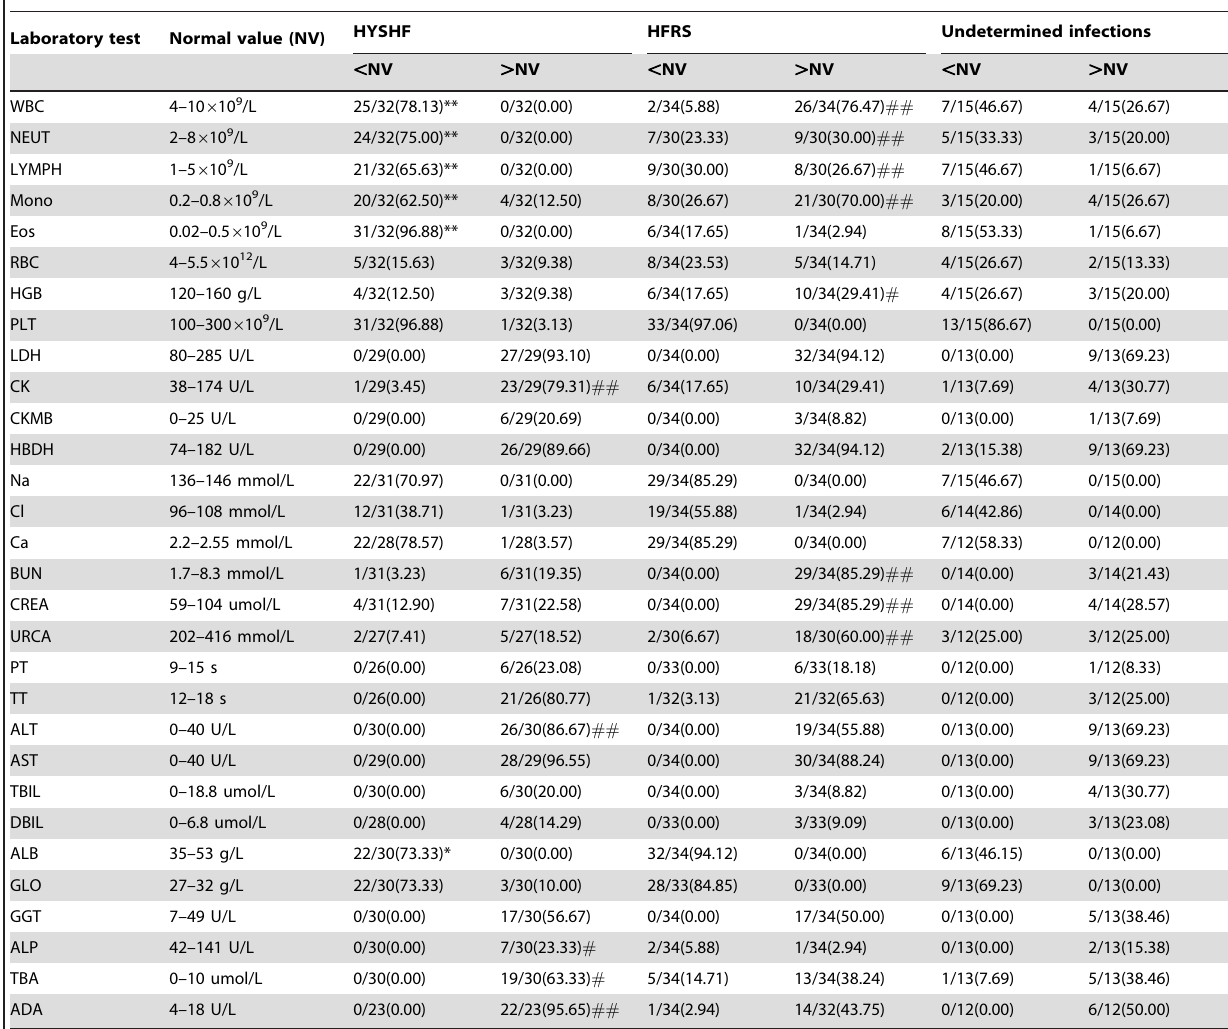
Table 5. Laboratory parameters of the patients with